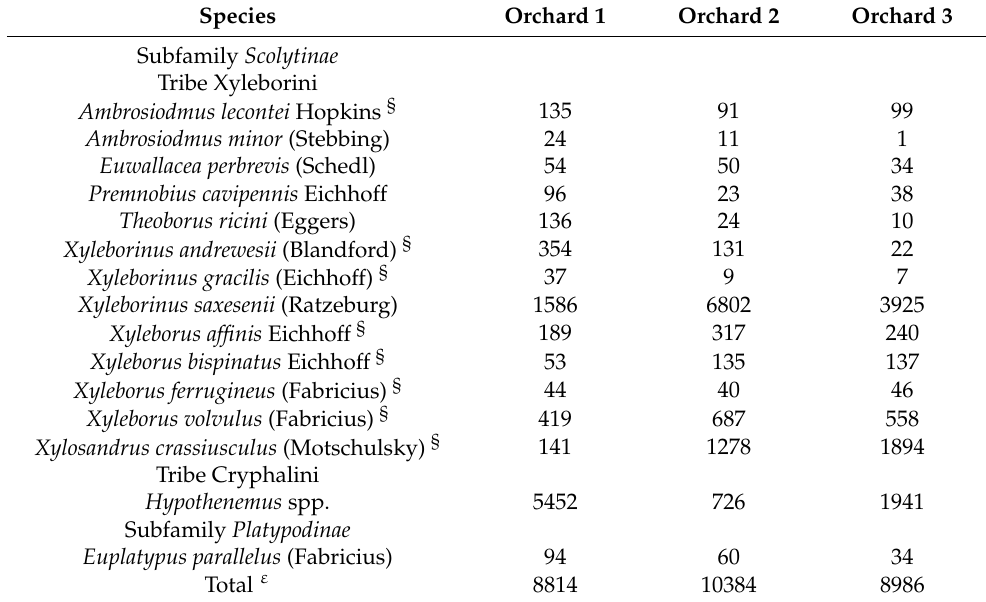
Table 1. Captures of Scolytinae and Platypodinae ( Coleoptera : Curculionidae ) species in unbaited Lindgren funnel traps deployed in three -avocado orchards affected by laurel wilt (Miami-Dade Co. FL). Species Orchard 1 Orchard